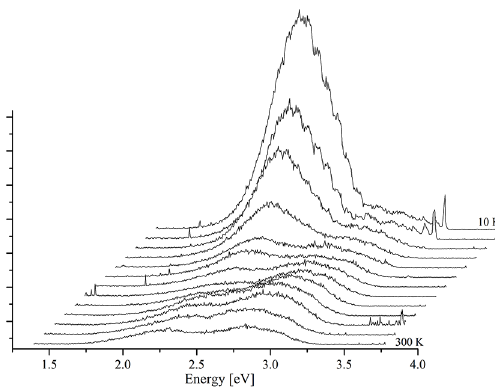
Figure 7. Temperature dependence of the PL spectra from 10 to 300 K for GaN film at the 2 nd point.